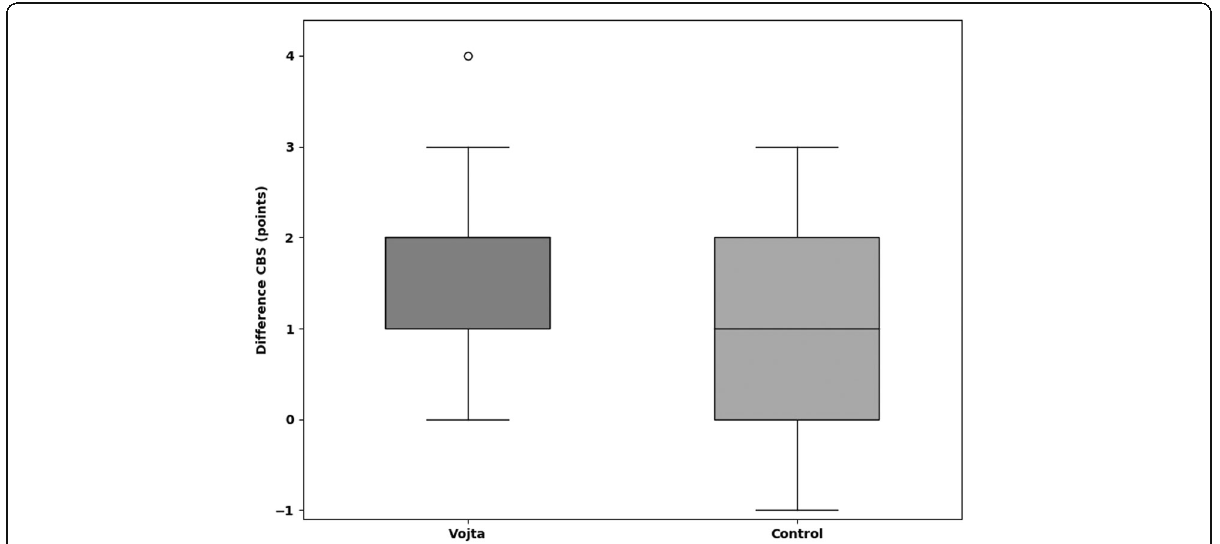
Fig. 3 Difference in Catherine Bergego Scale (CBS) scores between baseline and day 9. The median improvement in the CBS (Neglect test) within 9 days was 2 points (=33.3%) (IQR 1 – 2) in the Vojta group and 1 point (=16.6%) (IQR 0 – 2) in the control group ( p = 0.054). Data are presented as box-and-whisker